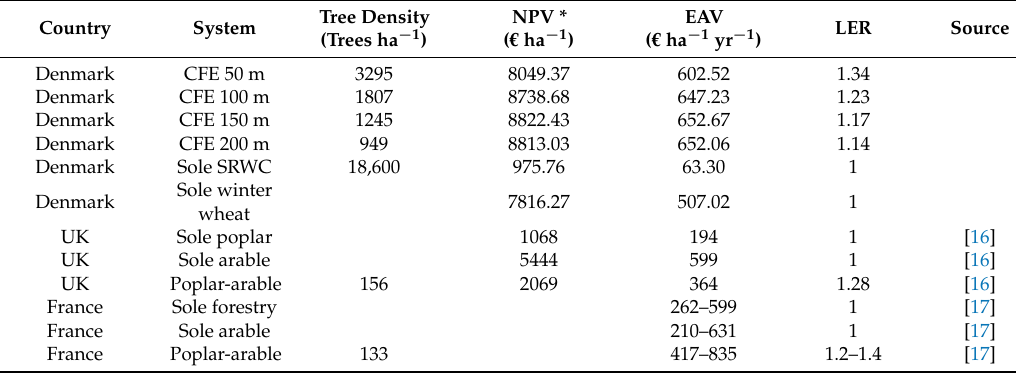
Table 4. Productivity and profitability values for a selection of sole crop and agroforestry systems, in terms of land equivalent ratio (LER), net present value (NPV), and equivalent annual value